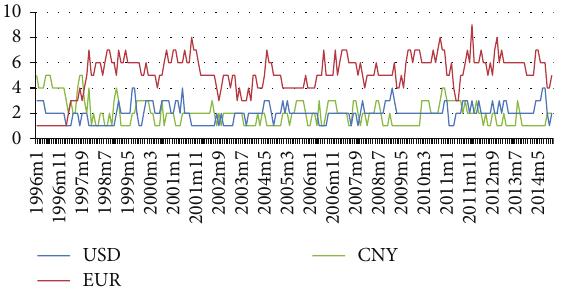
Figure 9: The number of links with respect to USD, EUR, and CNY (window length = 24 months).